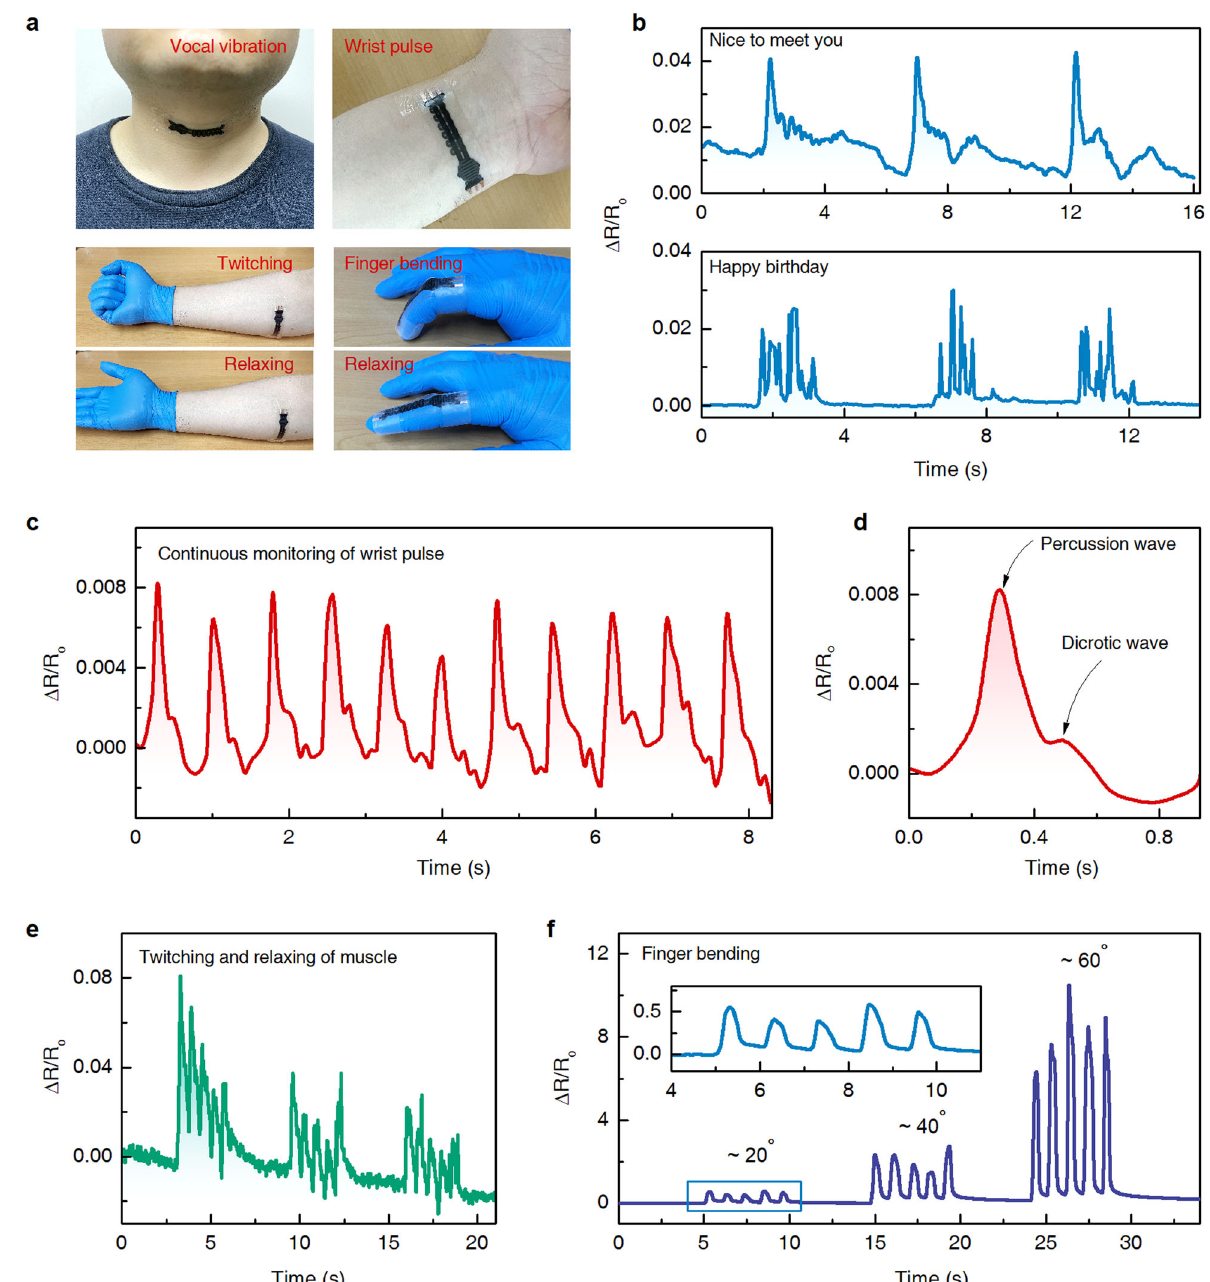
Fig. 4 Measurements of the human body induced deformations. ( a ) Photographs showing different locations to measure subtle to large human body-induced deformations. ( b ) Application of sensor as an arti fi cial throat depicting the response for pronunciation of ‘ happy birthday ’ (top) and ‘ nice to meet you ’ (bottom). ( c ) Real-time resistance response of the sensor for wrist pulse and ( d ) time-averaged eight pulse periods containing P-wave and D-wave. ( e ) Response of the sensor for muscle twitching. ( f ) The ability of the sensor for the human body induced large motion detection as fi nger bending and relaxing. (Photo credit: Ashok Chhetry, Kwangwoon the skin via epidermal electrodes. The suitability of the LIG/ the relative change in resistance of 0.011 and 0.013 at an upper and lower temperature, respectively con fi rm the viability of the MXene-Ti 3 C 2 T x @EDOT composite material for ECG measurement LIG/MXene-Ti 3 C 2 T x @EDOT composite material for the stretchable was con fi rmed by evaluating epidermal biopotentials. To measure strain-insensitive temperature sensor. ECG signals, the sensor was placed on the volunteer ’ s left wrist (LA) ensuring the bottom ECG electrode was contacted to the skin Physiological signal measurements and the top electrode (RA) was touched by the right hand ’ s fi nger (Fig. 5f). Owing to the high conductivity of LIG/MXene-Ti 3 C 2 T x @E- Human epidermal biopotentials, such as ECG are signi fi cant for DOT (LME) electrode, impedance spectra as a function of the diagnosis and treatment of heart-related diseases. These frequencies were measured in the frequency range from 4 Hz to biopotentials can be transduced by electrically interfacing with